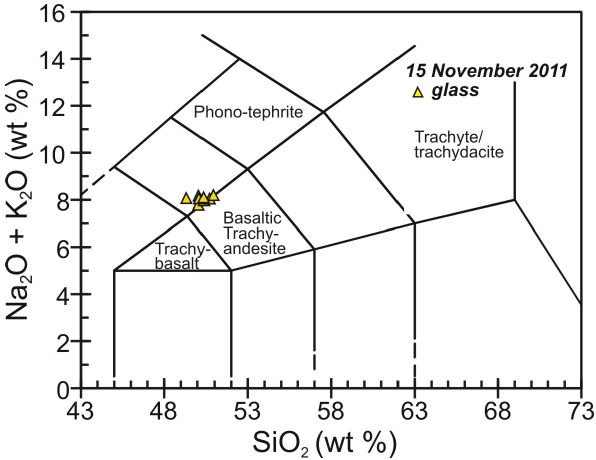
Figure 8. Total alkali–silica classification diagram of Le Bas et al. (1986).